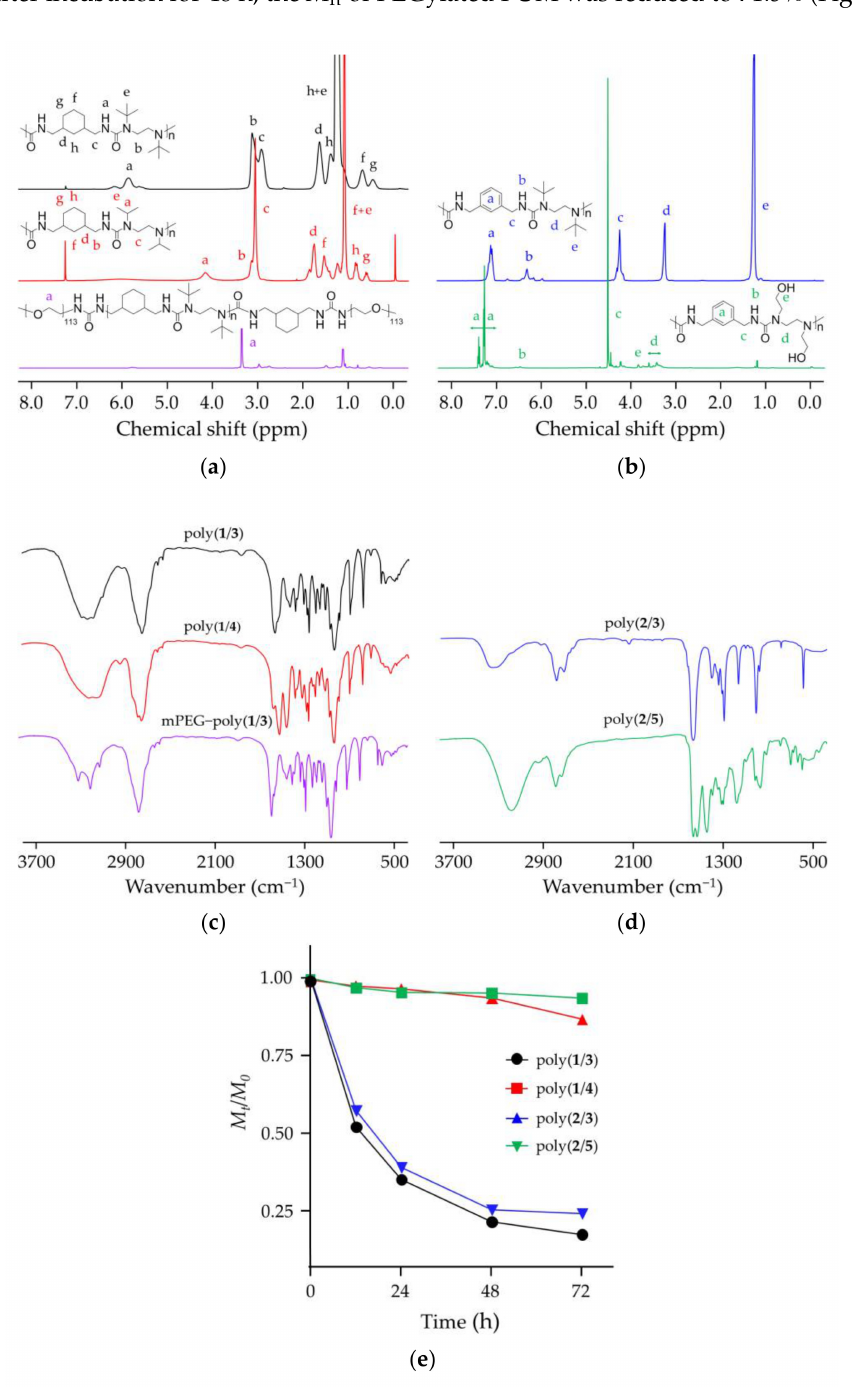
Figure 1. Characterizations of polyureas bearing hindered urea bonds (HUBs). ( a ) Proton nuclear magnetic resonance ( 1 H NMR) spectra of poly( 1 / 3 ), poly( 1 / 4 ), and mPEG − poly( 1 / 3 ) in deuterated chloroform (CDCl 3 ); ( b ) 1 H NMR spectra of poly( 2 / 3 ) and poly( 2 / 5 ) in CDCl 3 ; ( c ) Fourier-transform infrared (FT-IR) spectra of poly( 1 / 3 ), poly( 1 / 4 ), and mPEG − poly( 1 / 3 ); ( d ) FT-IR spectra of poly( 2 / 3 ) and poly( 2 / 5 ); ( e ) Changes of number-average molecular weights ( M n s) of four polyureas with di ff erent chemical groups by gel permeation chromatography